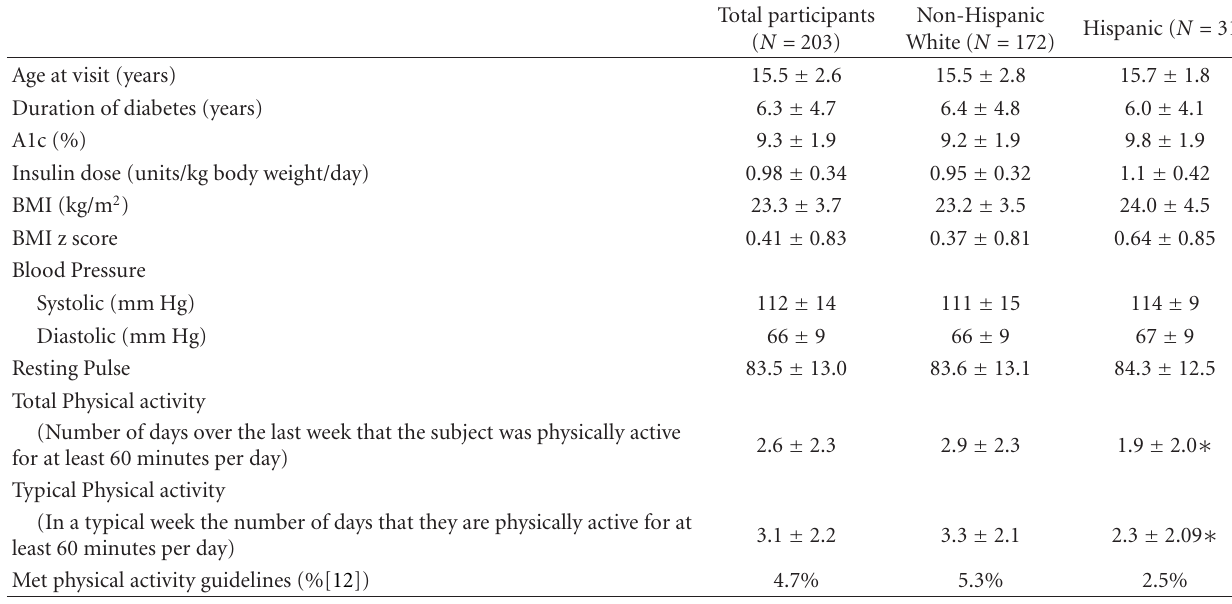
Table 1: Characteristics of study participants.